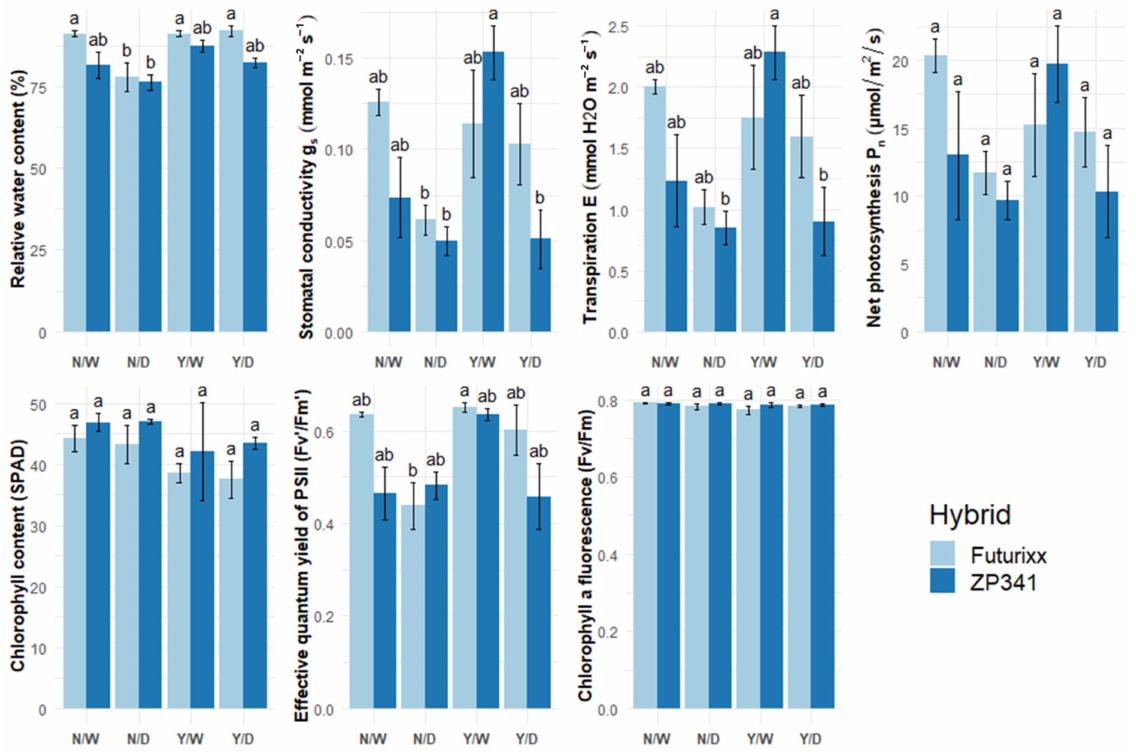
Figure 2. Physiological parameters of two maize hybrids subjected to herbivory (no wireworms (N) vs. wireworm-infested (Y)) and to two watering regimes (well-watered (W) vs. water-deficient (D)) on day 21. Data are presented as mean values ± SE (n = 4). Different letters indicate a significant difference between treatments ( p <